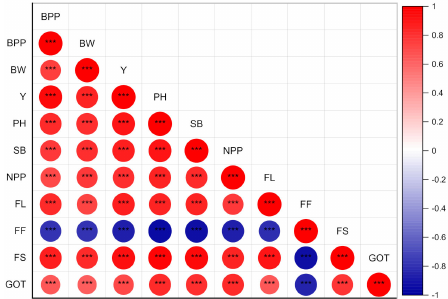
Figure 3. Pearson correlation of di ff erent cotton growth yield and quality attributes under di ff erent levels of soil and seed dressing potassium humate. PH = potassium humate; BPP = bolls per plant; BW = bolls weight; Y = cotton seed yield; PH = plant height; SB = sympodial branches; NPP = nodules per plant; FL = fiber length; FF = fiber fitness; FS = fiber strength; GOT = ginning out